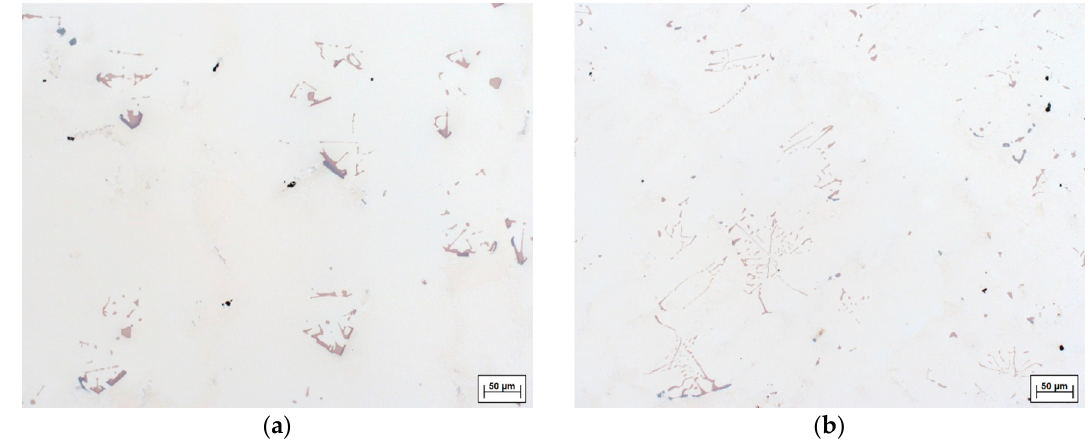
Figure 6. Morphology of carbides in LC-SC samples of MAR-M247 directionally solidified at: ( a ) 0.13 K ∙ s (cid:2879)(cid:2869) ; ( b ) 0.4 K ∙ s (cid:2879)(cid:2869) .